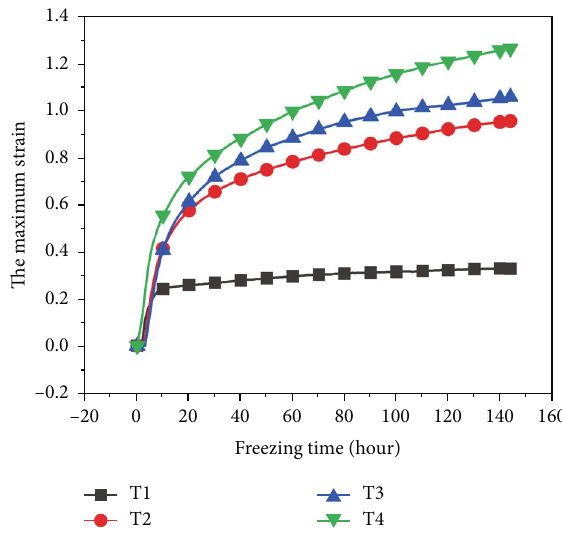
Figure 14: Variation of the maximum strain at the segregation position of the soil column with